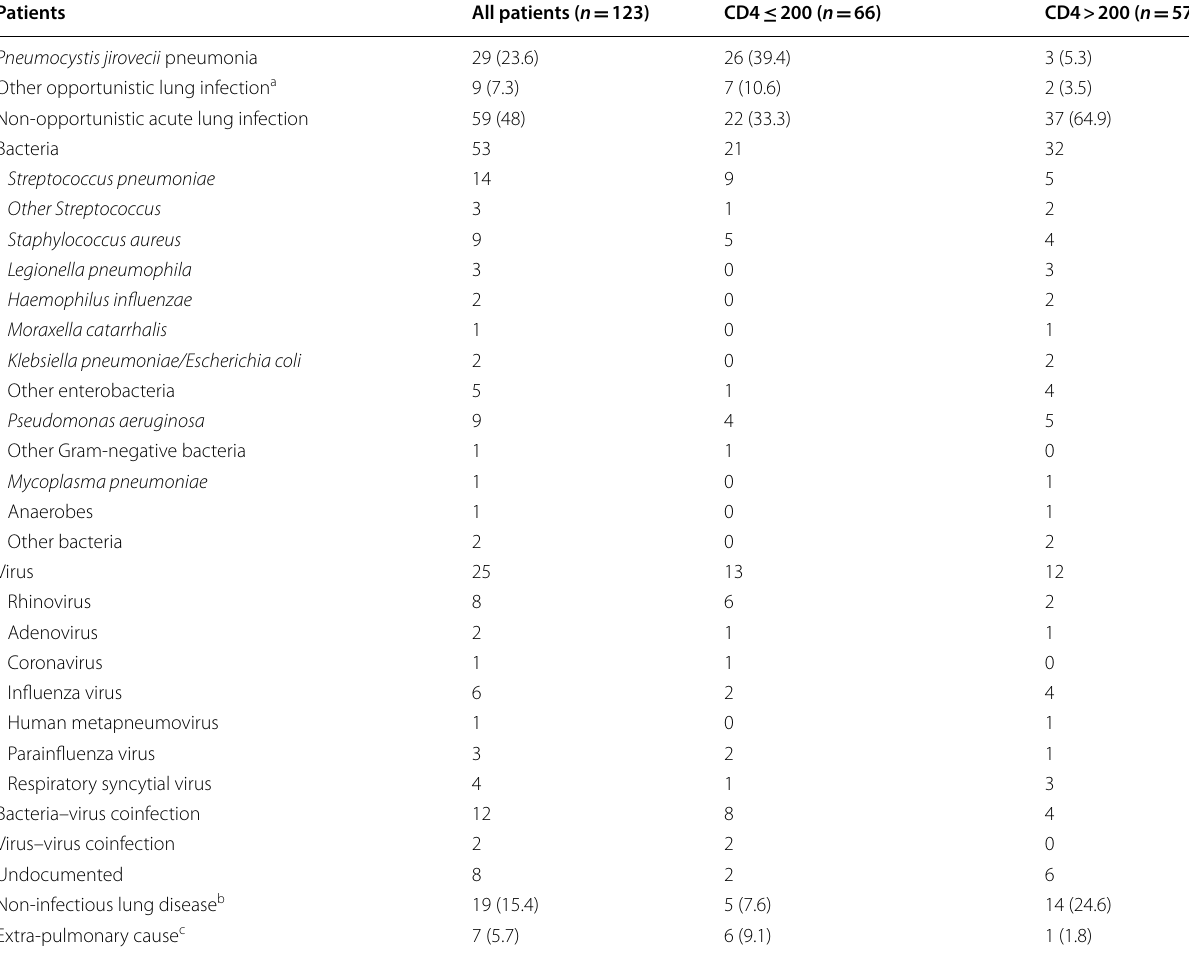
Table 2 Causative diagnosis of acute respiratory failure in 123 HIV-infected patients admitted to the